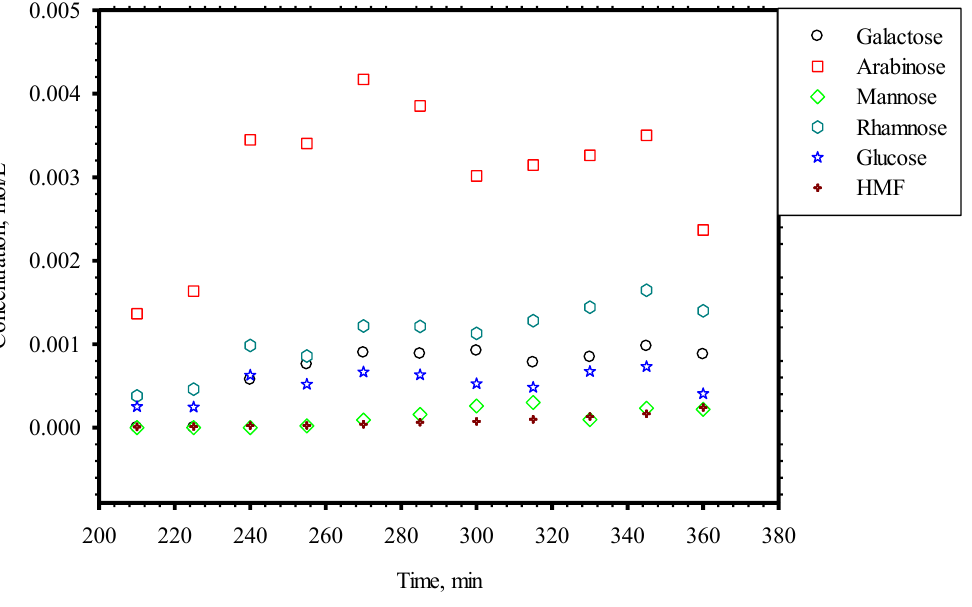
Figure 6. Variations of monosaccharides as a function of extraction